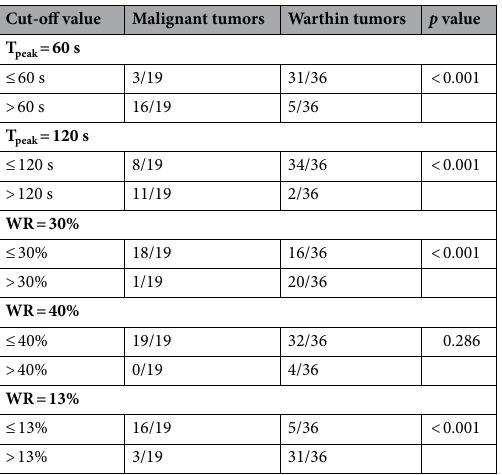
Table 3. Frequency of identifying parotid lesions as Warthin tumors and malignant tumors depending on the cut-off values for T peak and WR used as diagnostic